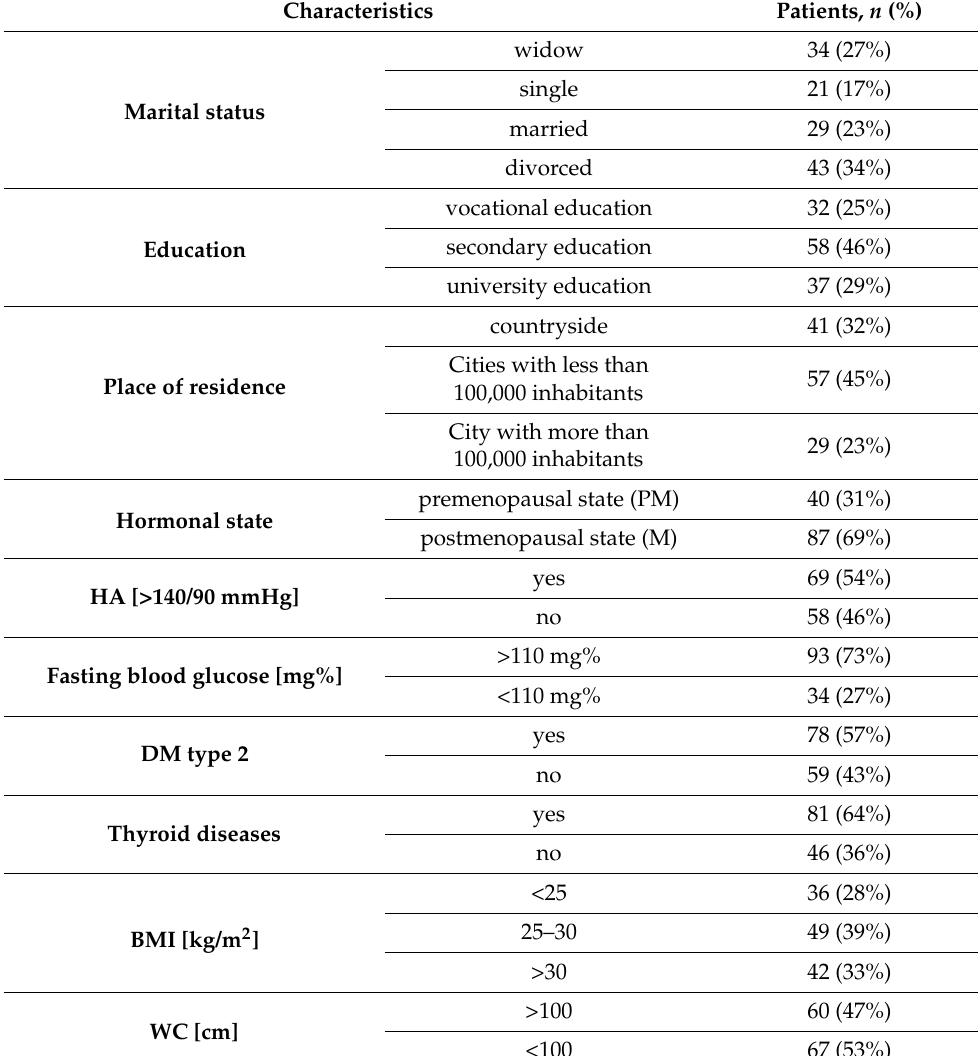
Table 2. Characteristics of patients divided into subgroups: BMI, body mass index; WC, waist circumference; HA, arterial hypertension; DM type 2, diabetes mellitus type 2.